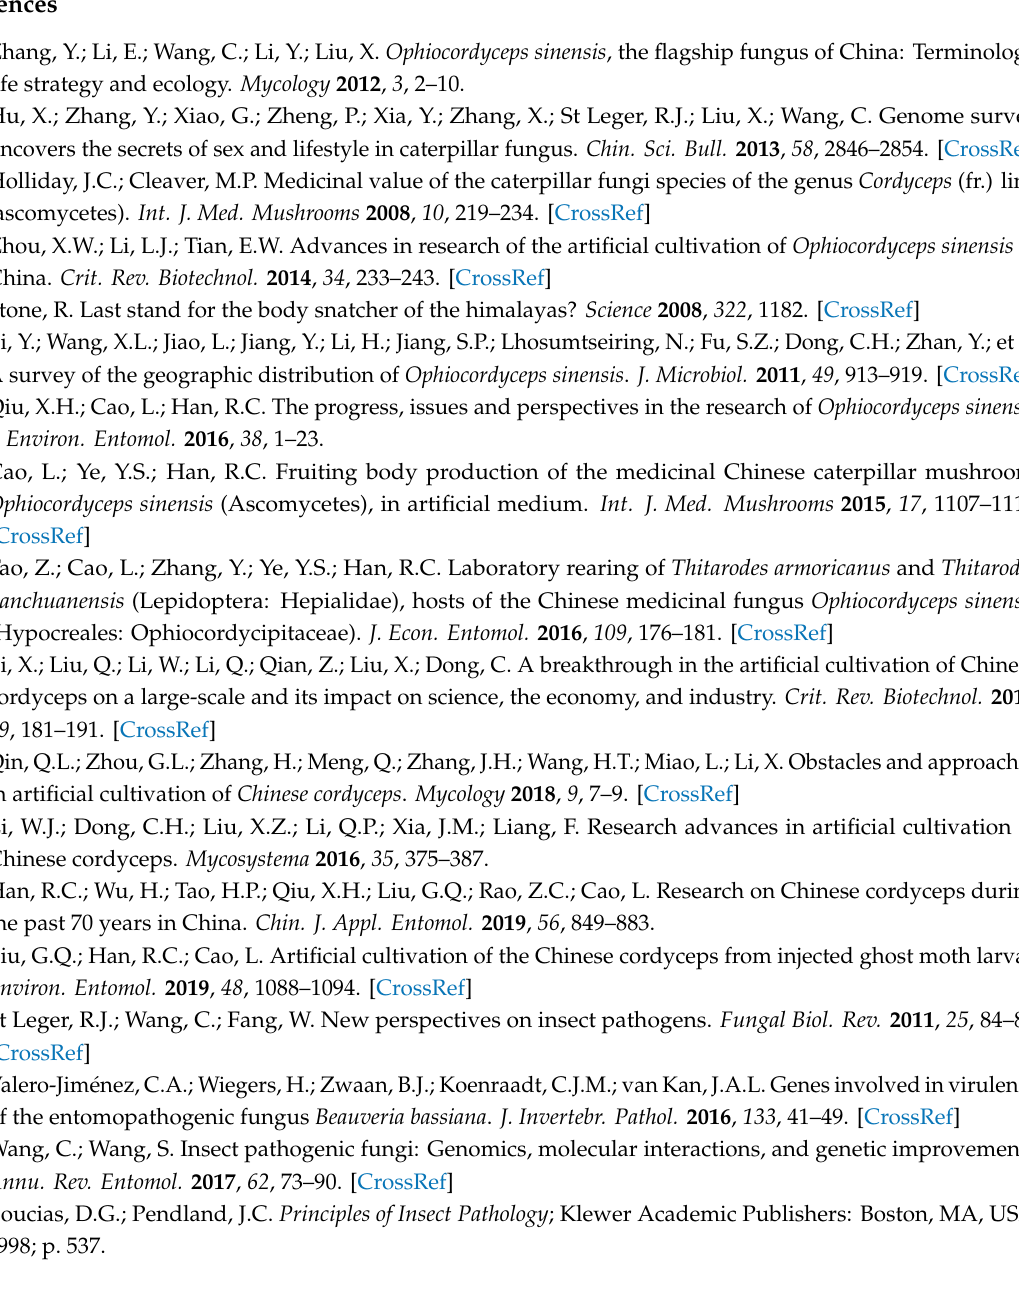
Figure S1: E ff ect of solvent DMSO (A-B) and EtOH (C-D) on blastospores budding growth and hyphal formation, Figure S2: E ff ect of insect hormones (JHI, JHII and JHIII) on blastospores budding growth (A, C, E) and hyphal formation (B, D,